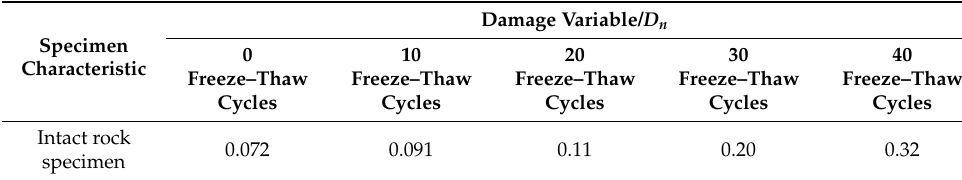
Table 2. Damage variable of the shear modulus with freeze–thaw